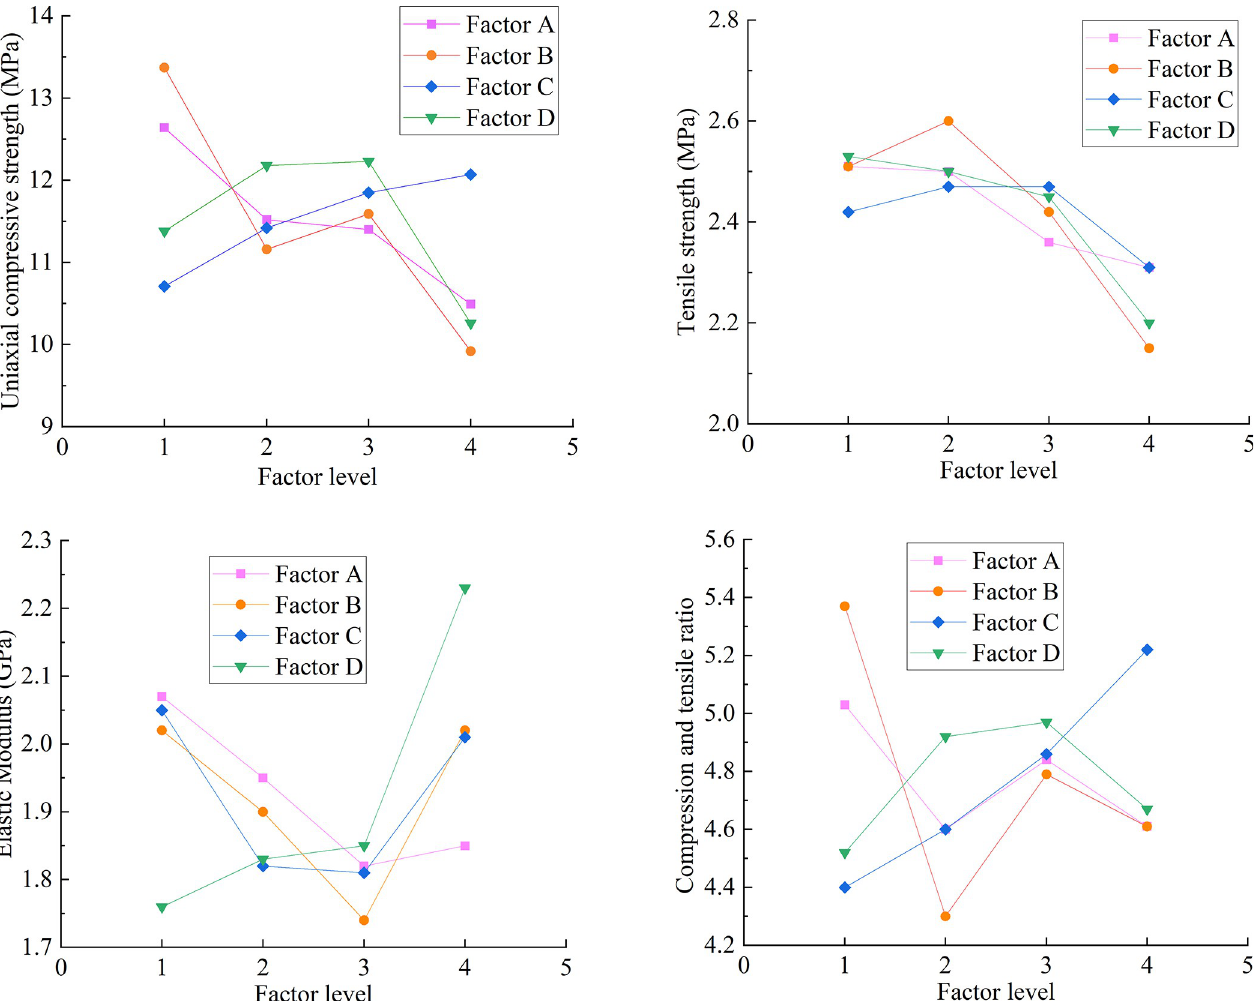
Fig 5. Main effects of range analysis. (a) Influences of various factors on compressive strengths of rockburst-like materials. (b) Influences of various factors on tensile strengths of rockburst-like materials. (c) Influences of various factors on the elastic moduli of rockburst-like materials. (d) Influences of various factors on the compressive tensile ratios of rockburst-like materials.